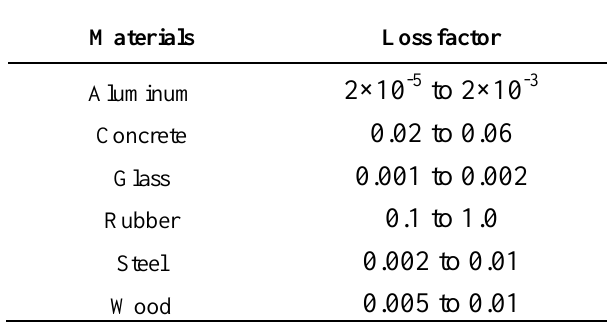
Table 1 . Loss factors of conventional